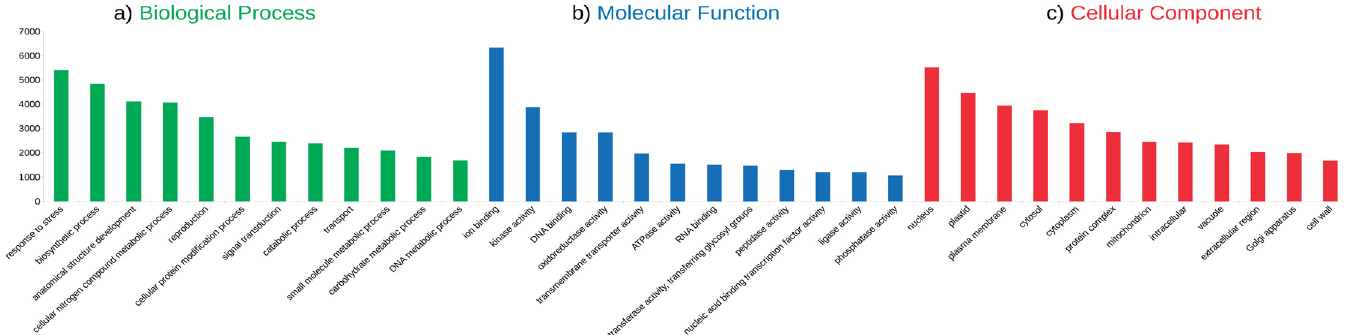
Fig 3. Histogram of GO classification of assembled Quercus ilex transcripts. Horizontal bar charts of the distribution of GO associated with the holm oak transcripts represented in the three main GO categories: biological processes ( a ), molecular functions ( b ) and cellular components ( c ). The first twelve transcripts assigned to each GO category are shown and the remaining transcripts assigned to each GO category are shown in S1